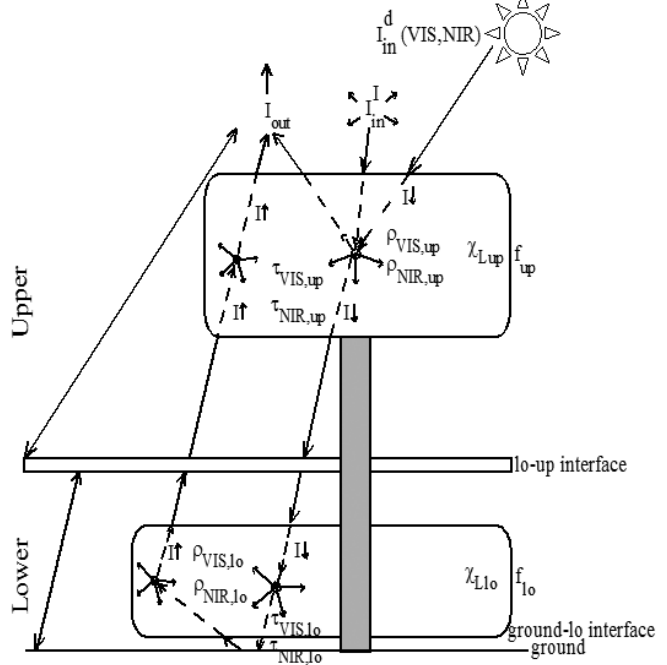
Fig. 1 – Schematic representation of the radiative transfer model in